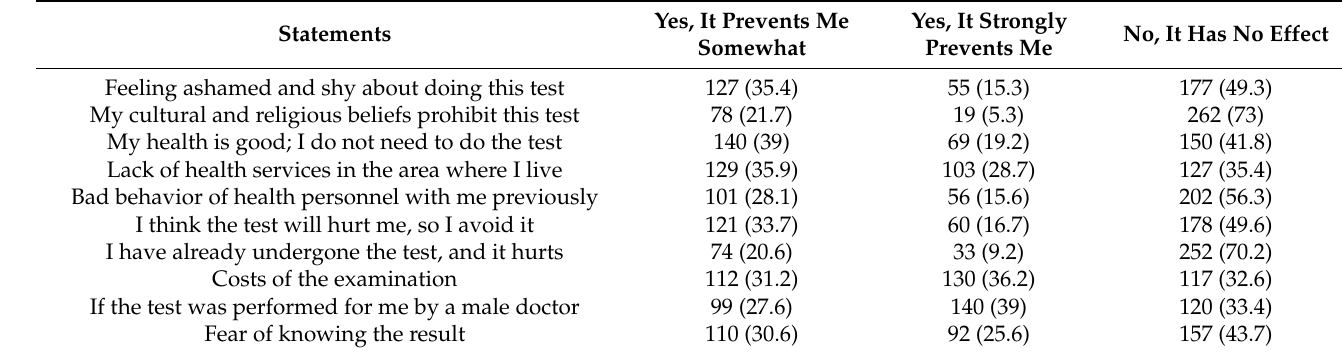
Table 6. Participants’ attitudes toward refusing routine cervical cancer